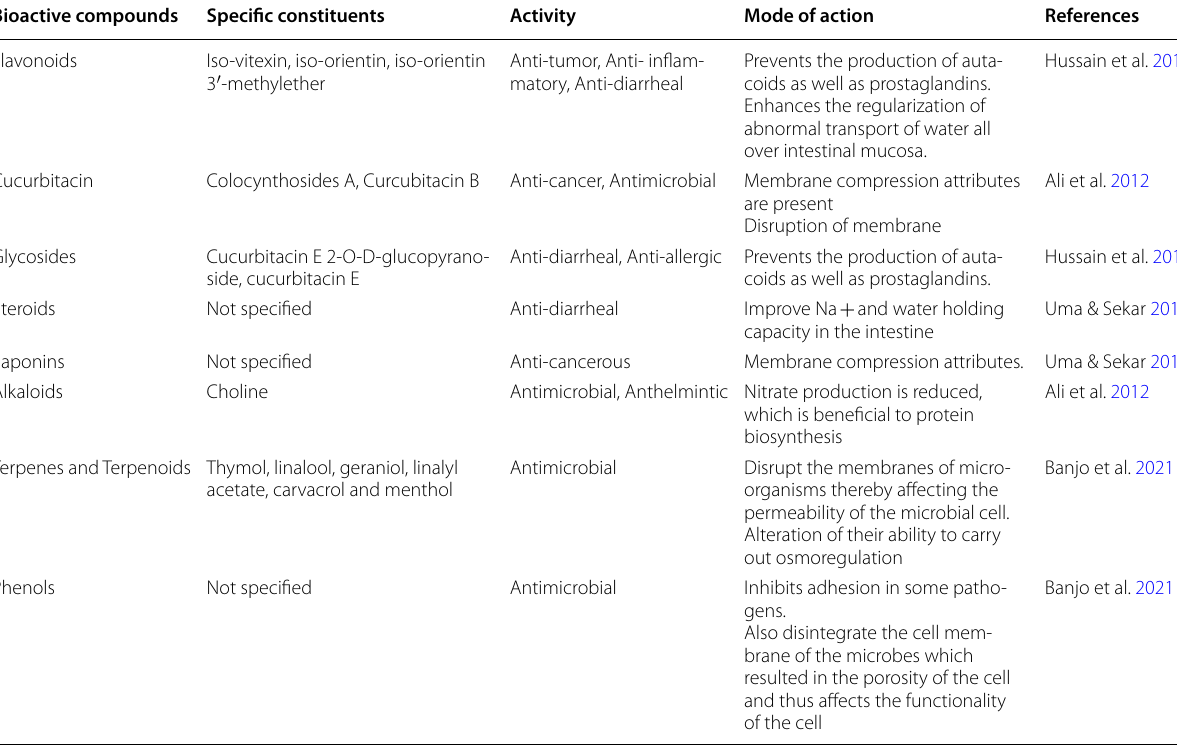
Table 2 List of different bioactive compounds present in different parts of bitter apple and their mode of